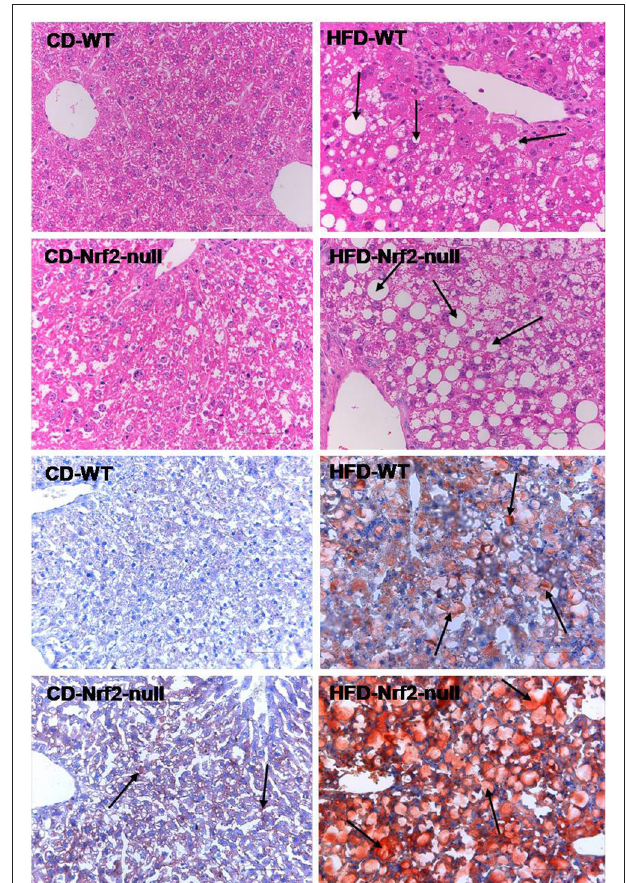
FIGURE 1 | Mouse hepatic pathology. Liver sections of the former four figures were stained by hematoxylin and eosin. Liver sections of the latter four figures were stained with Oil Red O and the fat accumulated in hepatocytes manifested red. All the liver sections were examined by light microscopy and the images were displayed at 200 × the original magnification. The fat accumulation in hepatocytes were pointed out by the arrows in HFD